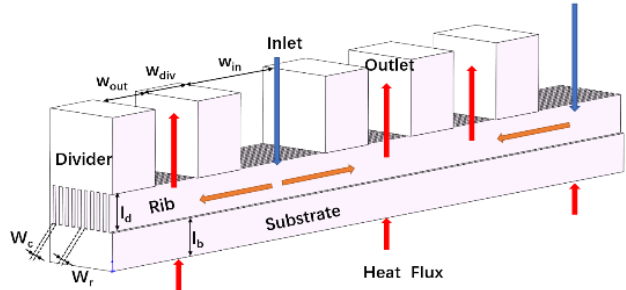
Figure 6. A schematic diagram of single-layer structure from Drummond [29].